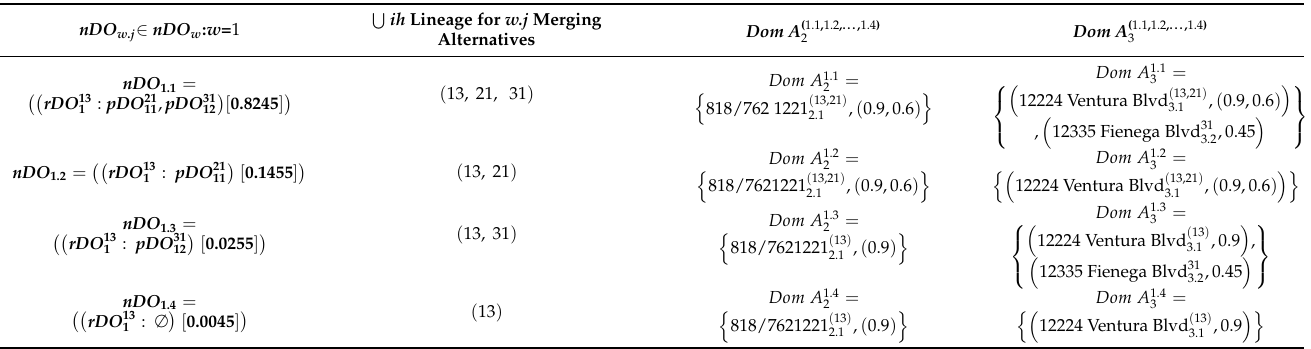
Table 2. Example of the probabilistic data fusion problem under the existence of multi- valued